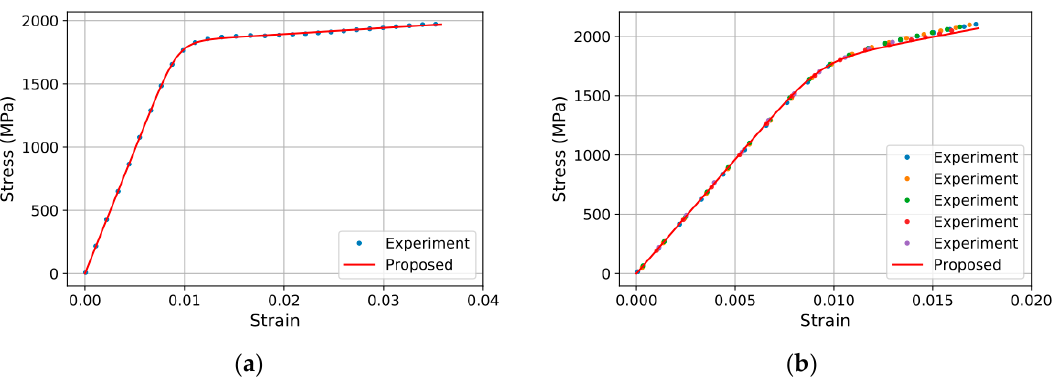
Figure 7. Comparison of experimental and analytical results: ( a ) steel strand; ( b ) smart strand.